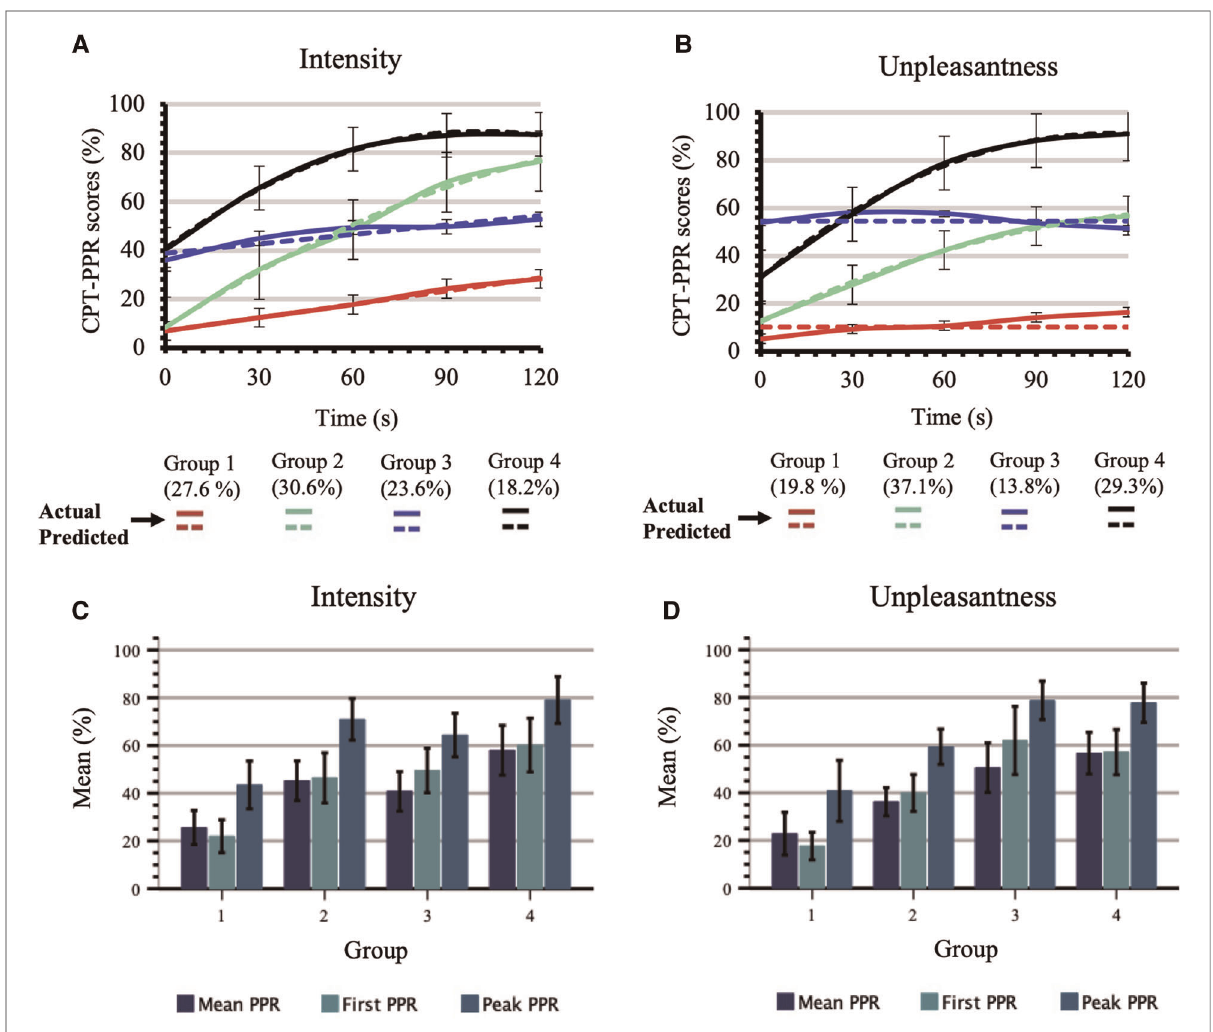
FIGURE 3 CPT-PPR trajectories and related PPR scores across groups. ( A ) CPT-PPR during 120 s by group trajectories for pain intensity scores. Each time point shows mean±SEM. ( B ) CPT-PPR during 120 s by group trajectories for pain unpleasantness scores. Each time point shows mean±SEM. ( C ) Scores for mean PPR, peak PPR, and fi rst PPR for the CPT-PPR subdivided by groups obtained in A. Each bar shows mean±95% CI. ( D ) Scores for mean PPR, peak PPR, and fi rst PPR for the CPT-PPR subdivided by groups obtained in B. Each bar shows mean±95% CI. All values are scored on a 0 to 100